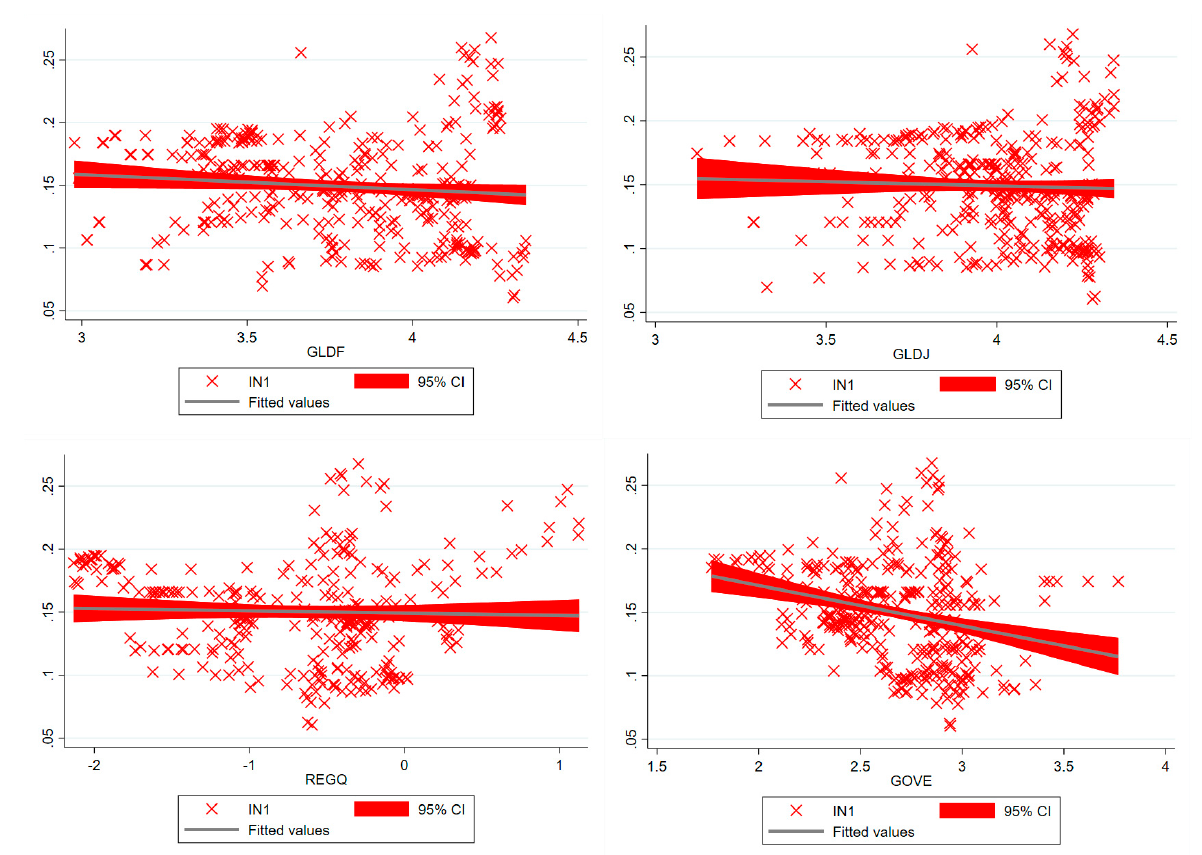
Figure 2. Fitted values for income inequality and globalization dynamics. Note: CI—Confidence interval. Legend: IN1—The income share of the top 1%, GLDF—Globalization de facto; GLDJ— Globalization de jure .